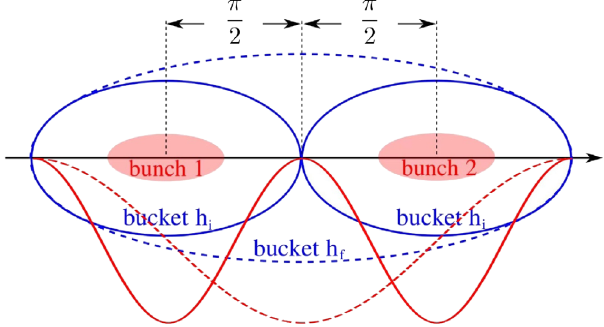
FIG. 2. Schematic of the initial positions of the two bunches (red shade) and the buckets in the initial harmonics h (solid blue) i and in the final harmonic h (dashed blue). The red solid and f dashed curves indicate the rf potential in the initial harmonic and in the final harmonic,